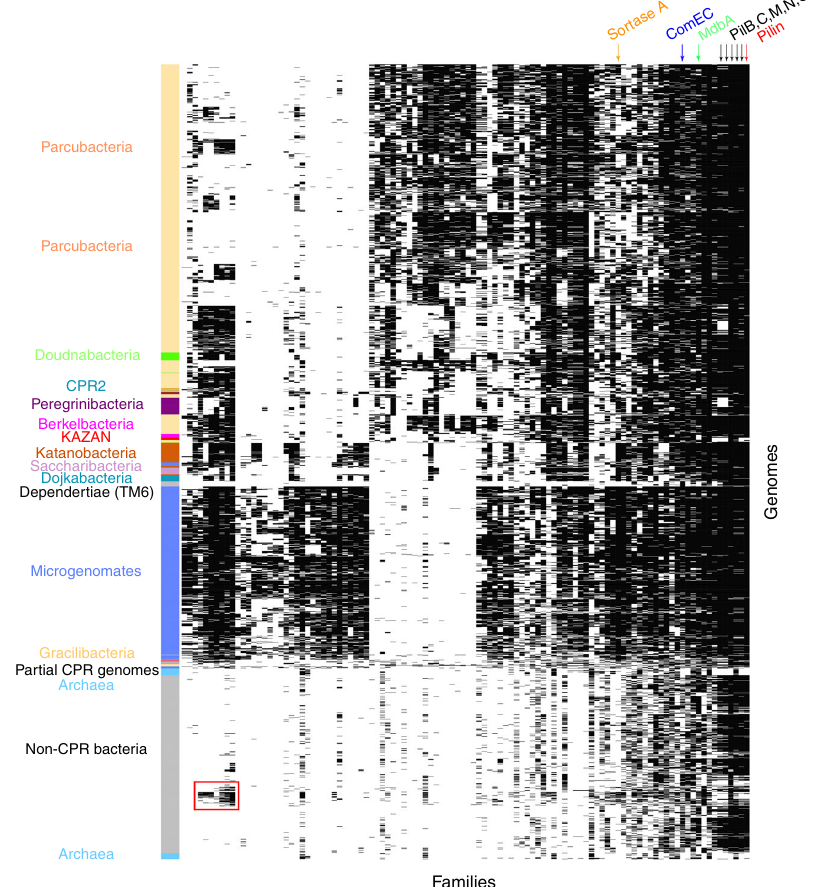
Fig. 6 Distribution of the 106 families that are enriched in CPR relative to non-CPR bacteria. The distribution of 106 protein families enriched in CPR (columns) in 2890 draft-quality and non-redundant genomes (rows) from a reference set with extensive sampling of genomes from metagenomes. The order of the families and the genomes is the same as in Fig. 3A